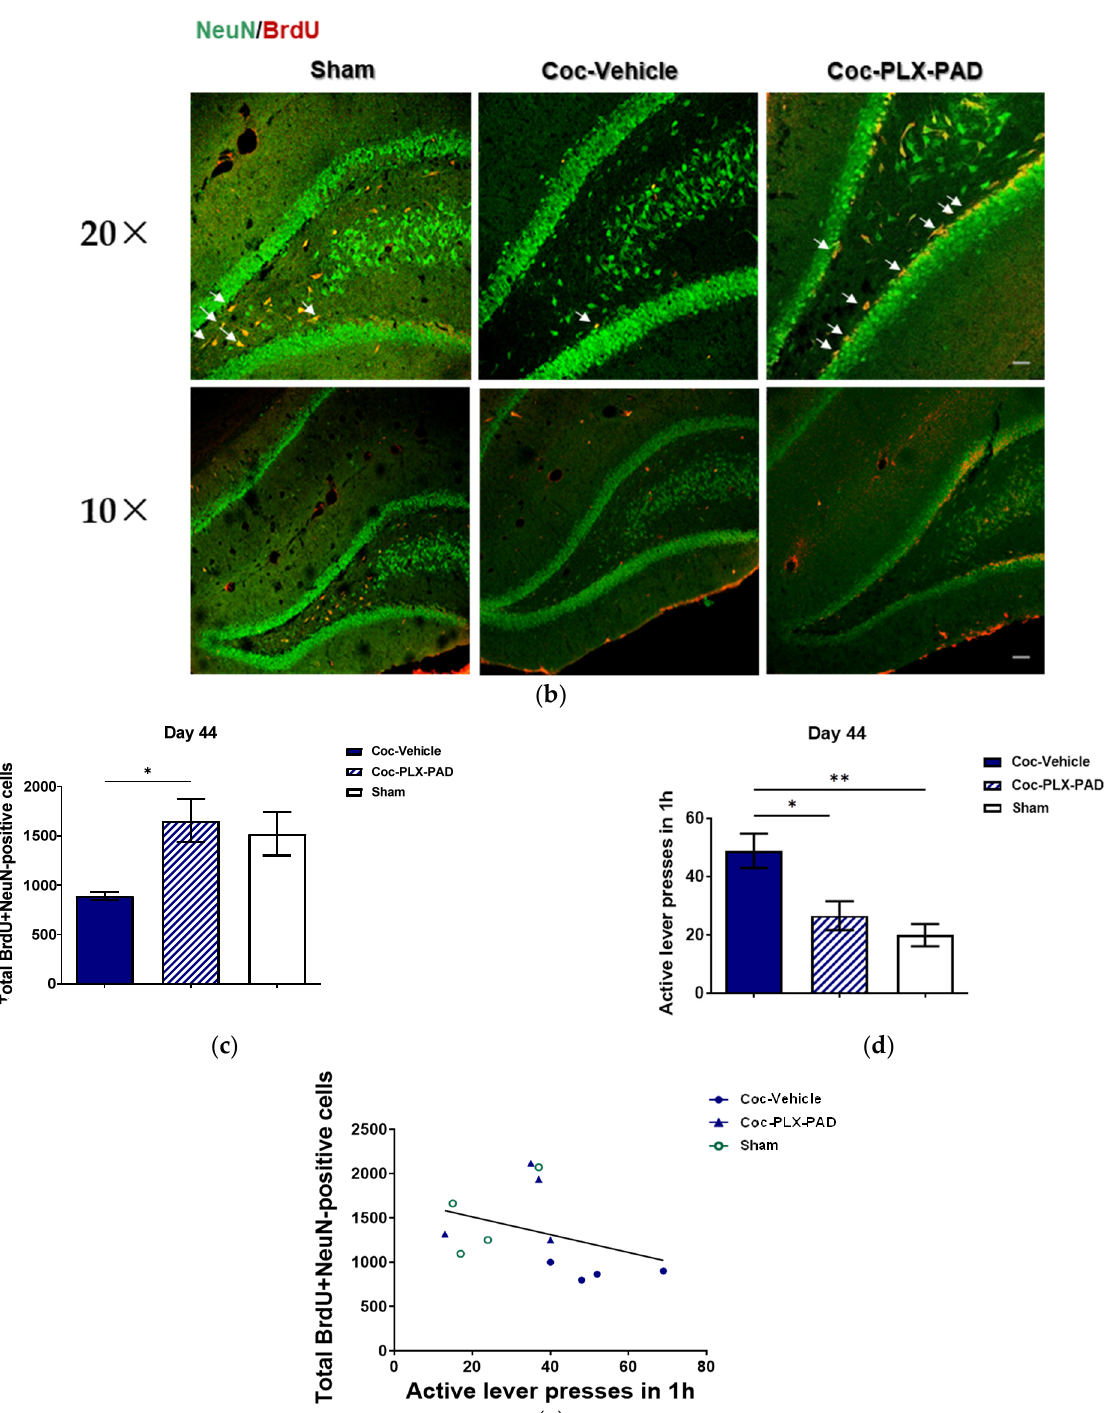
Figure 4. Effect of PLX-PAD cells on neurogenesis in the hippocampus. ( a ) Experimental design. Rats underwent cocaine or saline self-administration on Days 1–14, as in Figure 1. Cocaine-trained rats were treated IN with PLX-PAD or the vehicle (PlasmaLyte) on Day 15. On Day 16, all animals were injected with BrdU, a marker for neurogenesis (3 i.p injections at 4 h intervals). Animals underwent extinction training on Days 17–26. On Day 44, cocaine- and saline-trained animals were reinstated with cocaine or saline, respectively, and underwent the relapse test, as in Figure 1, after which rats were euthanized and perfused, and brains were excised. DG sections were stained for BrdU and NeuN, a marker of adult neurons; ( b ) Adult neurogenesis in the dorsal DG. Representative merged confocal microscope images of the dorsal DG from Day 44; ×:20; Scale bar: 50 µm, ×:10;